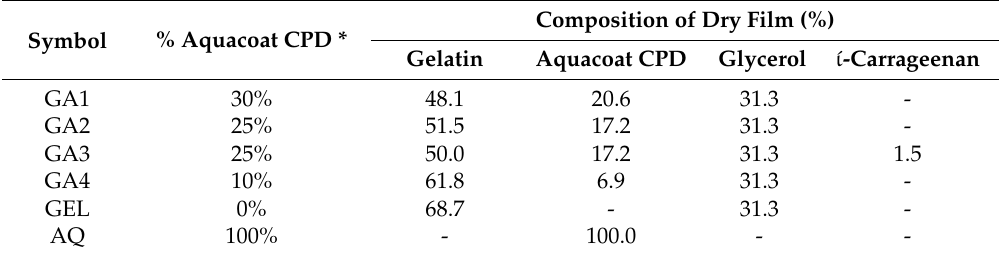
Table 1. Compositions of modified-and reference